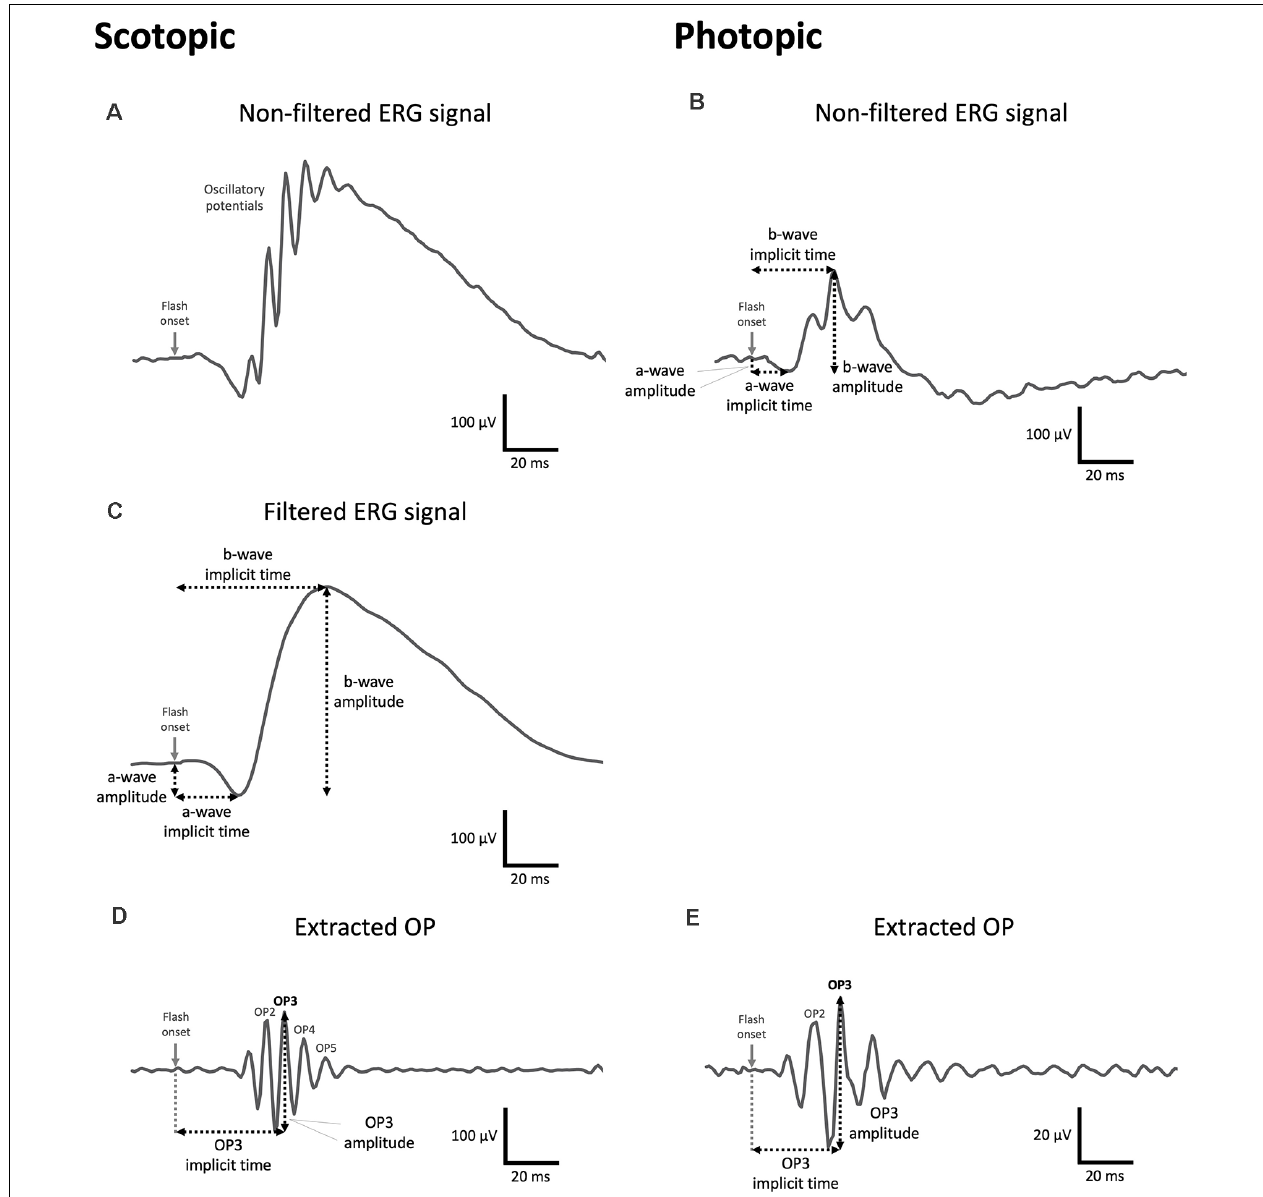
FIGURE 2 | Examples of a control mouse ERG waveforms obtained at 1.37 log cd.s/m 2 under photopic and scotopic conditions. (A,B) Example of a raw scotopic (A) and photopic (B) signal displaying OPs on the rising phase of the b-wave. (C) Every scotopic signal was filtered (digital band-stop: 75–300 Hz) prior to the identification of the a- and b-waves. (B,C) a- and b-wave amplitudes are calculated (in microvolts) from the baseline to the trough of the a-wave and, from there, to the peak of the b-wave, respectively. The implicit time corresponds to the total time (in milliseconds) from the flash onset until the trough of the a-wave or the peak of the b-wave are reached, respectively. Note in the scotopic condition that ERG components were obtained from filtered signals. (D,E) Scotopic (D) and photopic (E) OPs were extracted from raw signals by applying digital band-pass filtering (75–300 Hz). The OP amplitude is measured (in microvolts) from the peak of the OP to the preceding trough, while the implicit time (in milliseconds) is the total amount of time from the flash onset to the peak of the OP. The measurement of the amplitude and implicit time in OP3 is shown as an example in (D) and (E) but both ERG components were calculated for each individual OP. Note the vertical scale bar represents 20 µ V in (E)